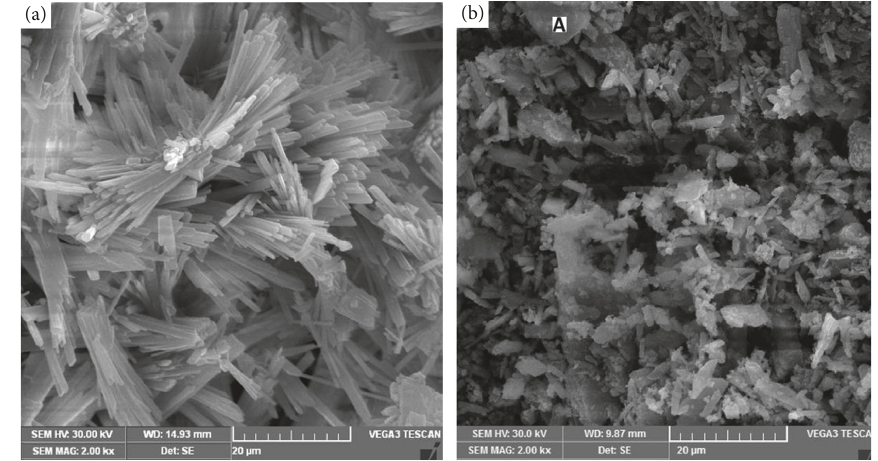
Figure 9: The microstructure of hardened (a) R-CP-0 and (b) R-CP-10.